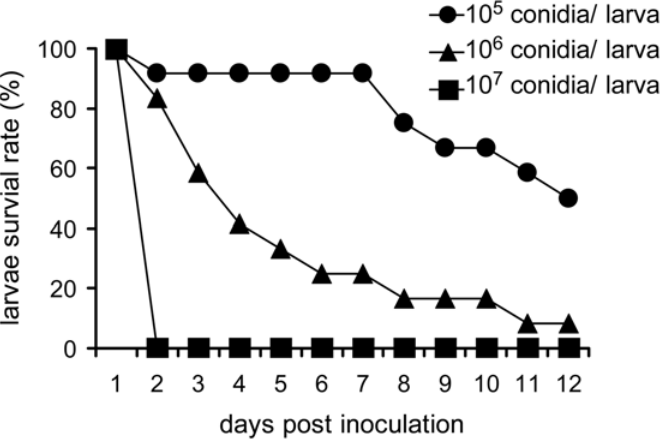
Figure 1. Dose dependent killing of G.mellonella larvae by A.fumigatus . G. mellonella larvae were inoculated with conidia of A. fumigatus strains Af293 at 1 6 10 5 , 1 6 10 6 , and 1 6 10 7 conidia per larva. The rate of G. mellonella survival was plotted against days post inoculation.